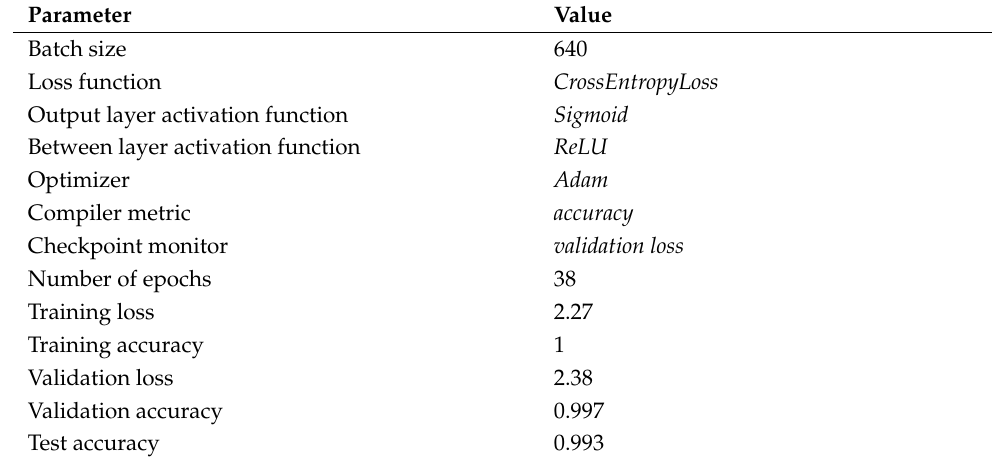
Table 7. Parameters of the best developed CNN-based fault classifier.